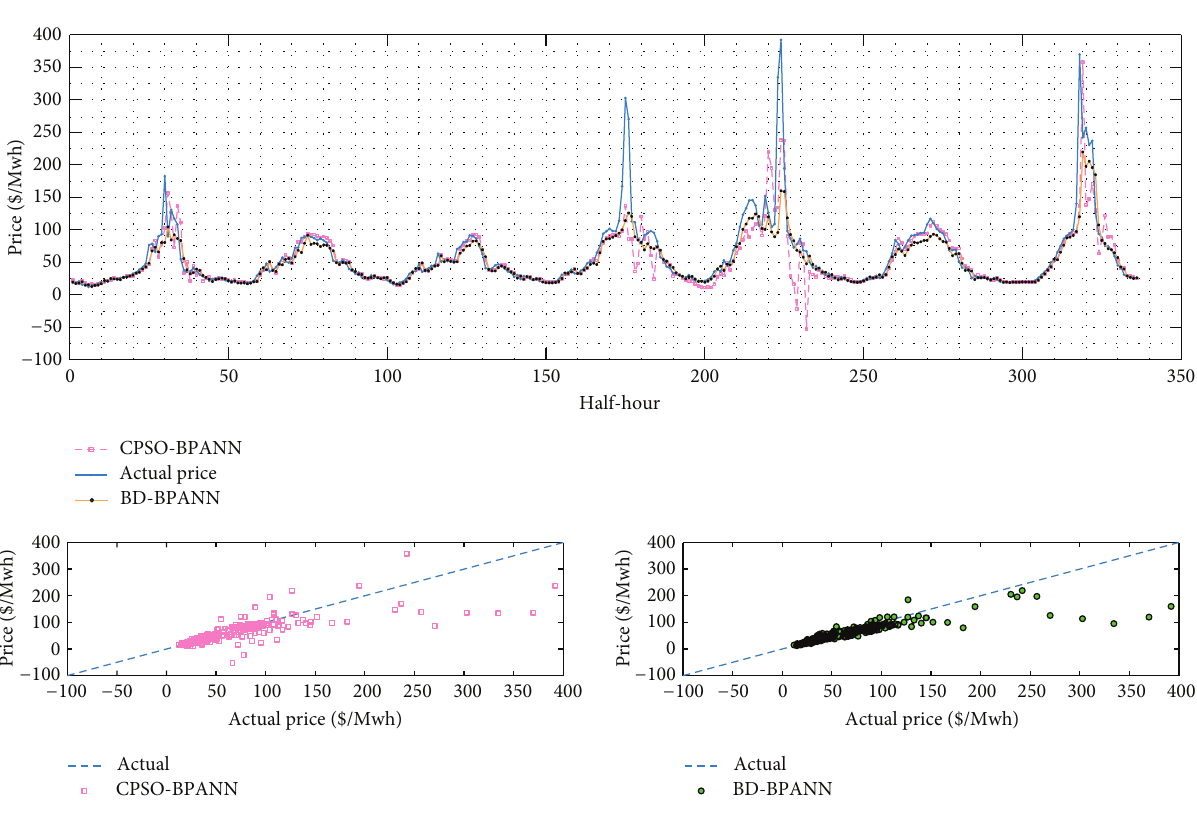
Figure 10: BD-BPANN and CPSO-BPANN methods for case